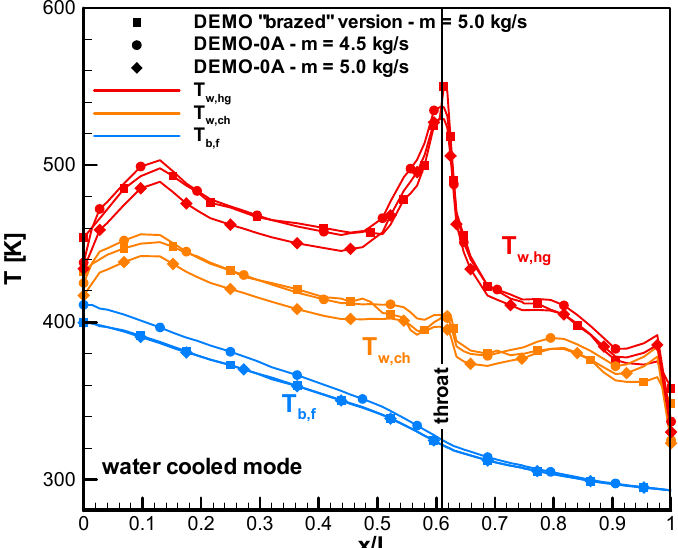
Figure 12. Water-cooled mode: axial profiles of hot gas walls, channel bottom walls and fluid bulk temperature.